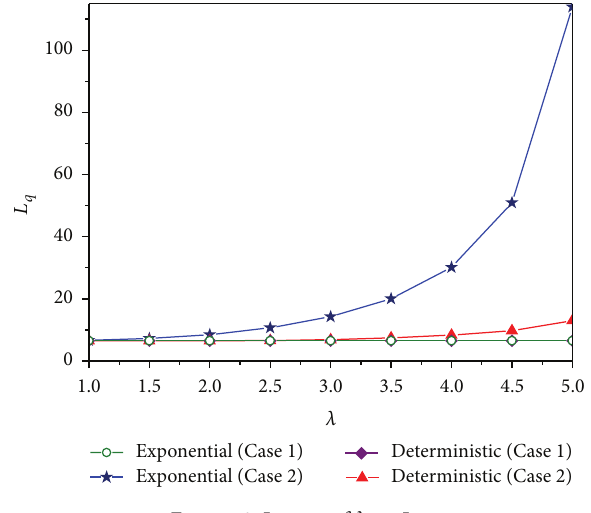
Figure 2: Impact of 𝜆 on 𝐿 𝑞